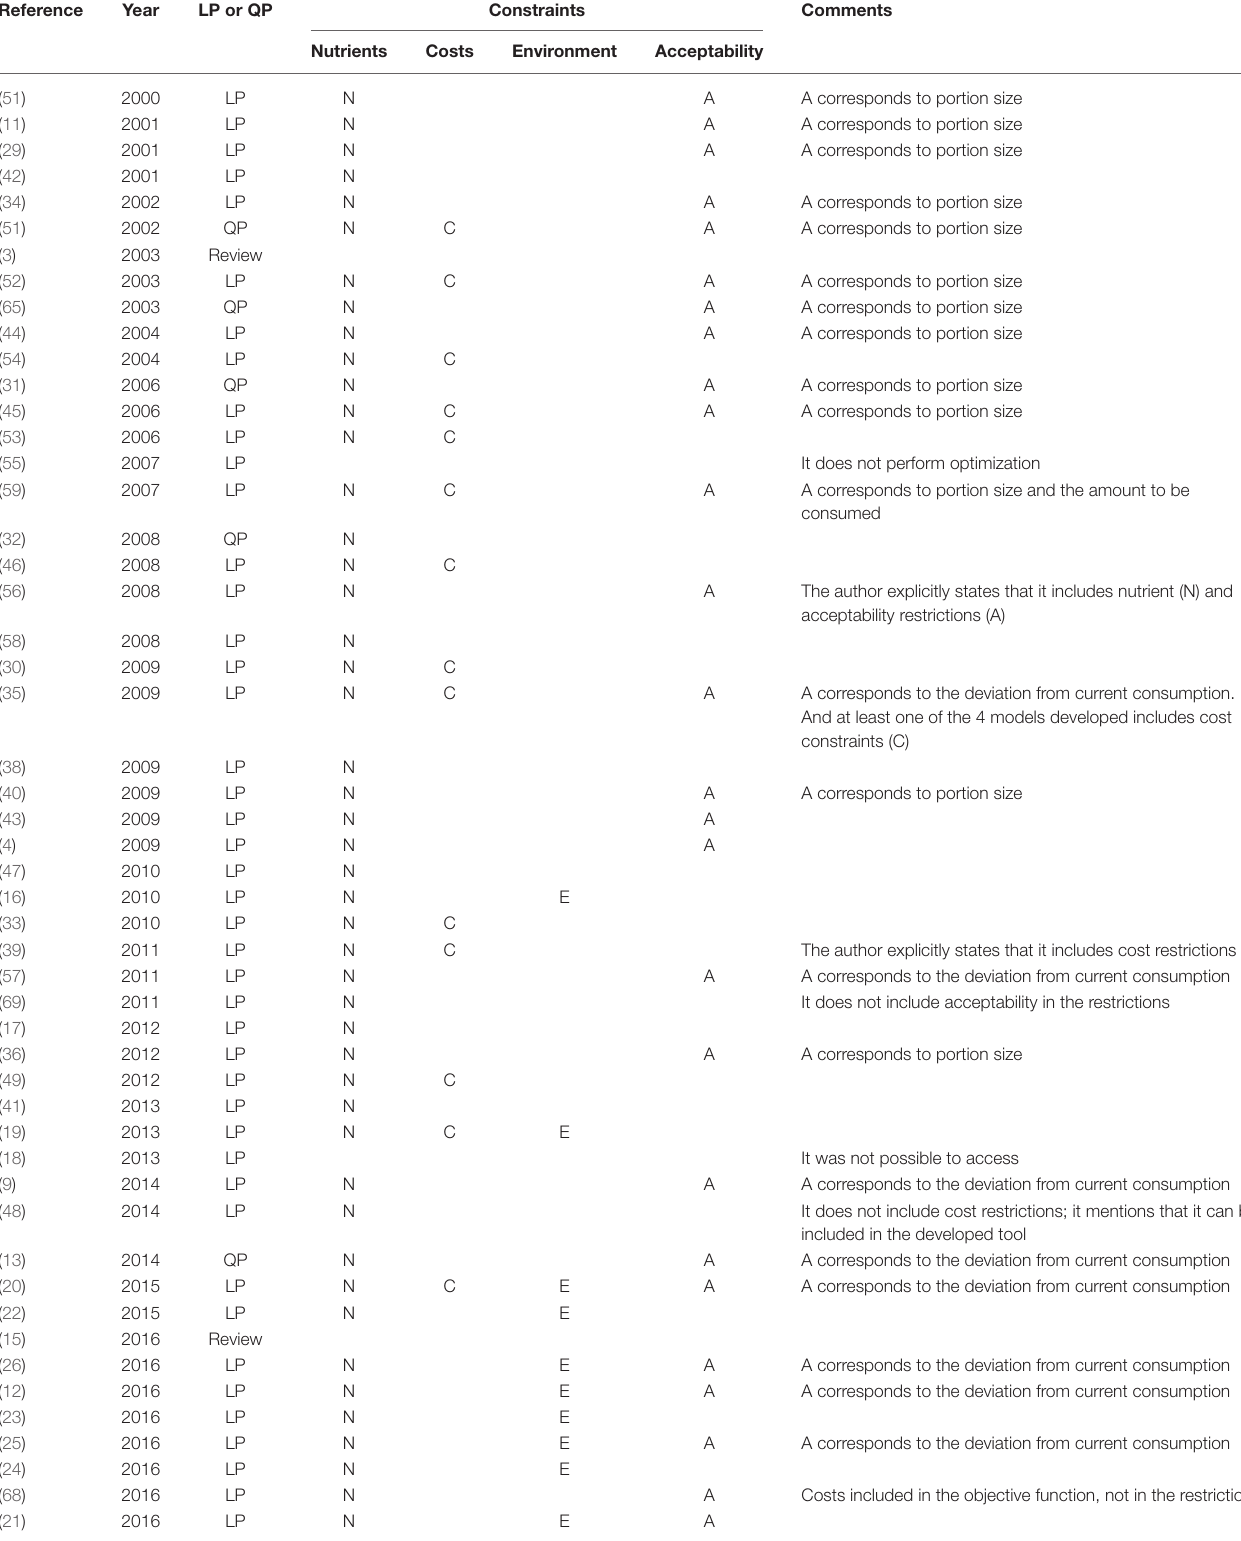
TABLE A1 | Short overview of the reviewed papers, year published, type of programming (linear or quadratic) and constraints used.